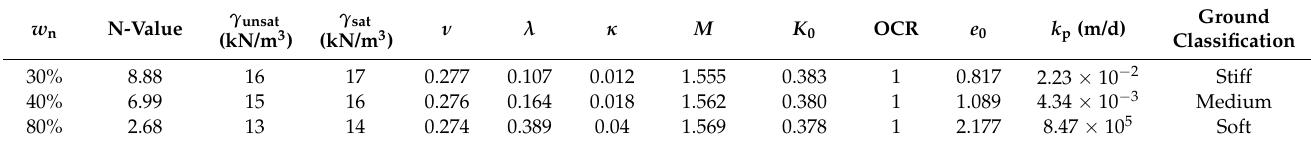
Table 1. Input parameters for the clays of different hardness.